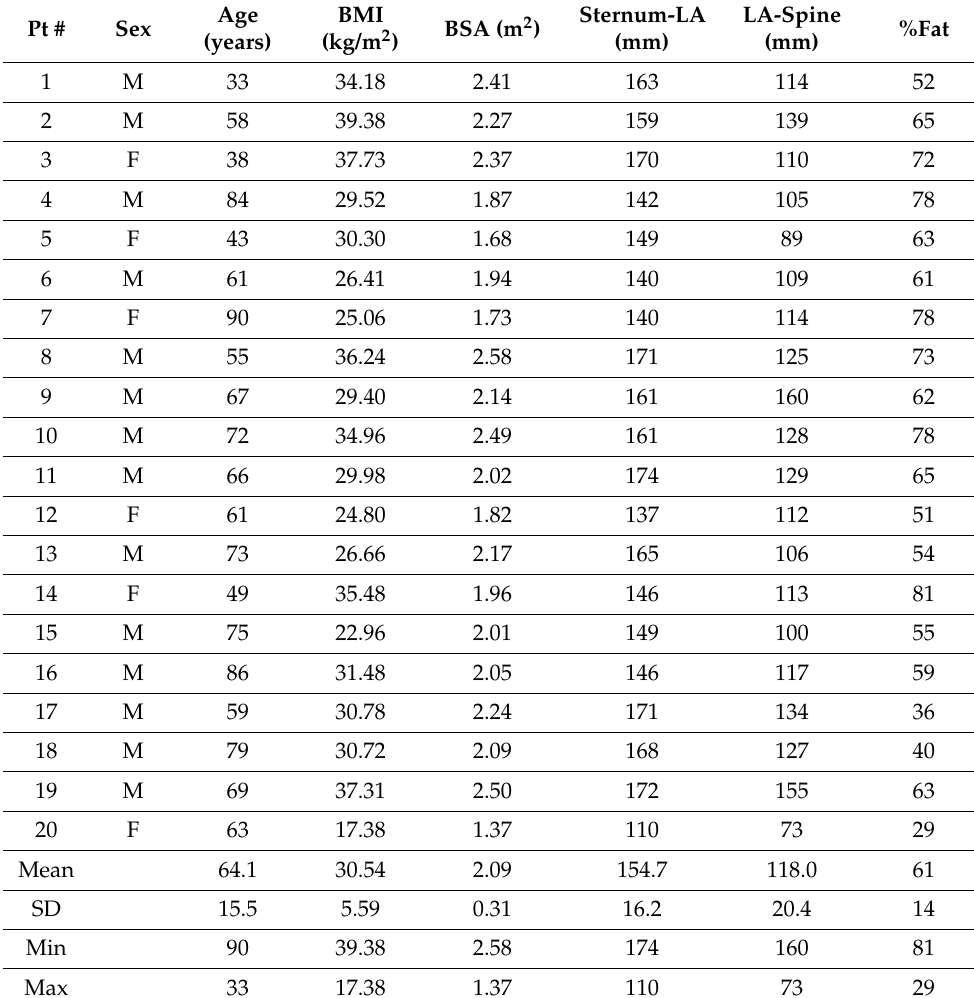
Table 2. Morphological data from the CT scans and percentage of fat relative to mixture skeletal muscle-fat surrounding the